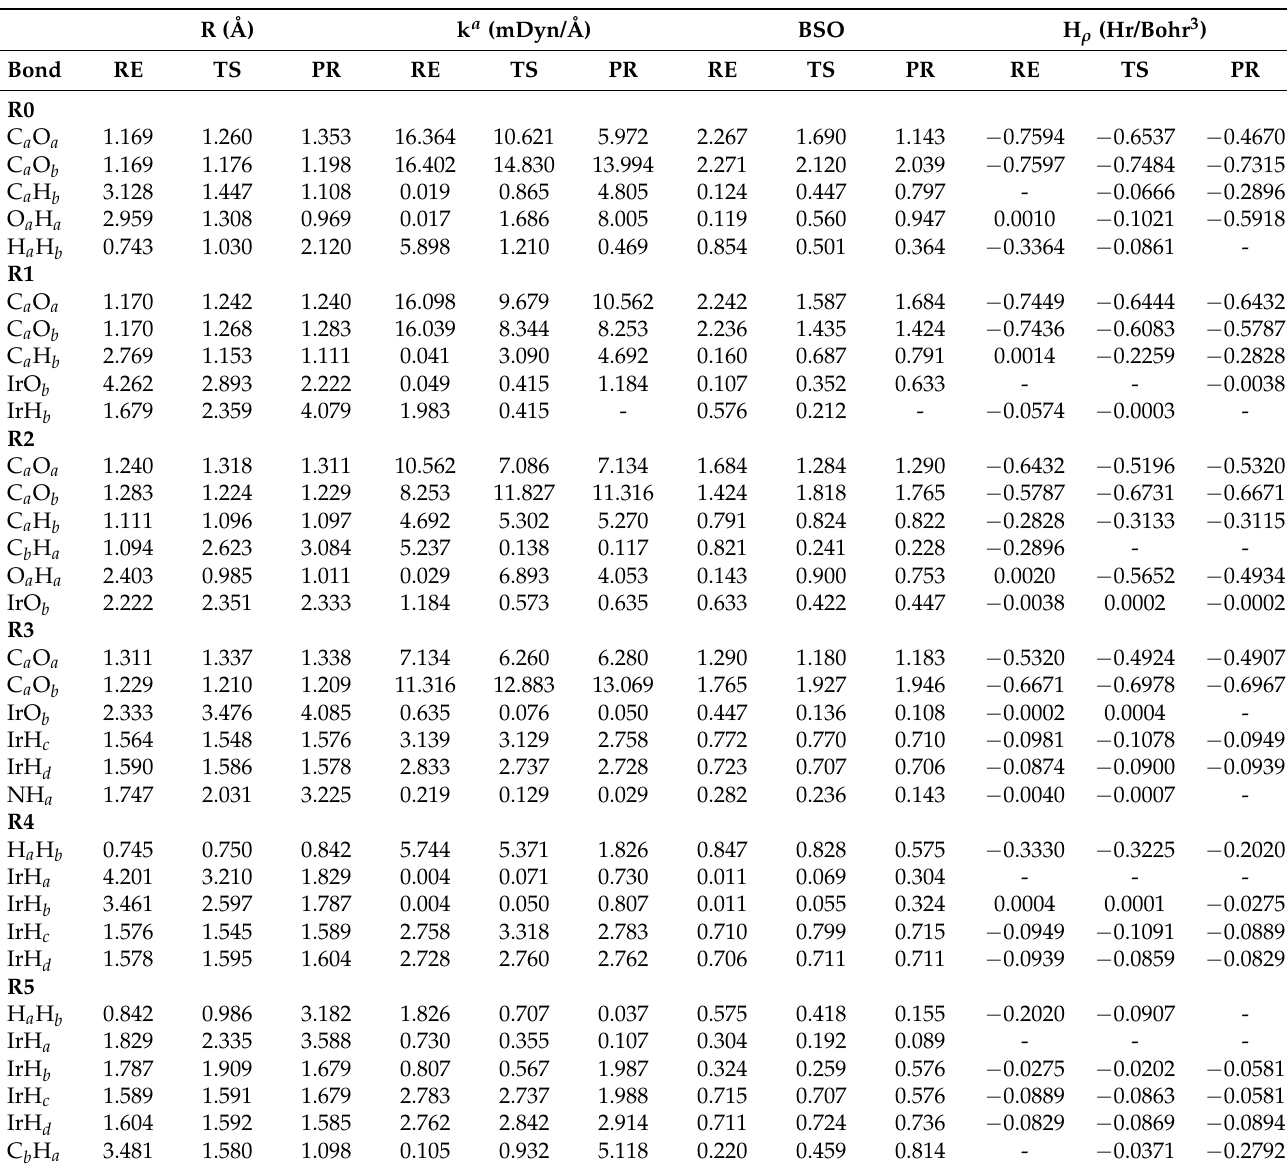
Table 3. Bond length R, local mode force constant k a , bond strength order BSO, and energy density H ρ of the selected bonds for reactant RE, transition state TS, and product PR of reactions R0 – R5 . For the bond label description, see the text. B3LYP/6-31G(d,p)/SDD(Ir) level of